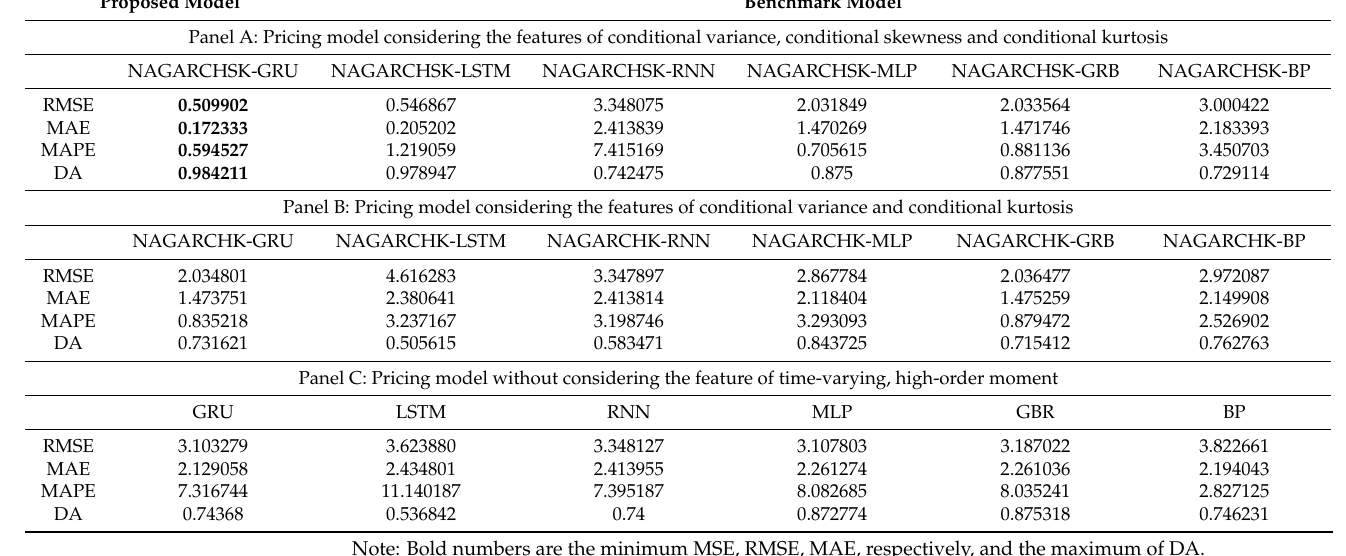
Table 3. Performance of the proposed and benchmark model for forecasting the carbon price.